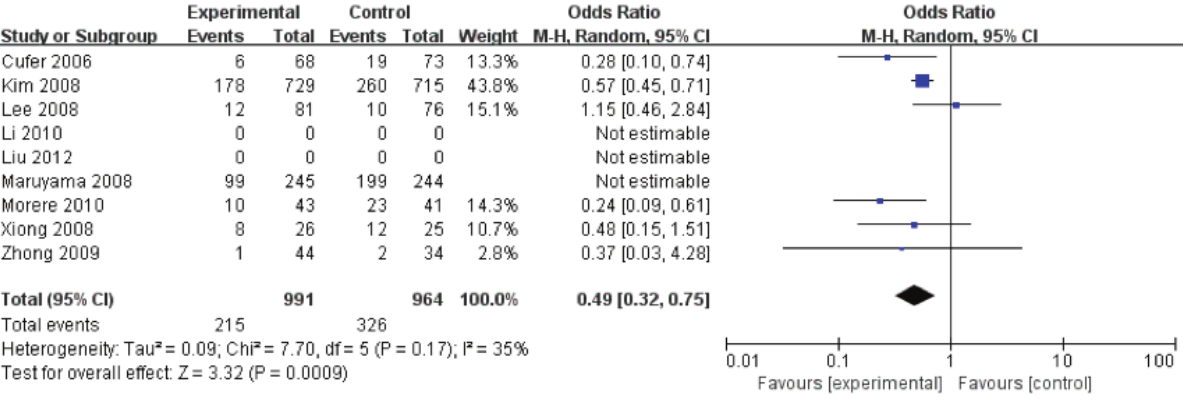
Figure 4: The comparison for the 3~4 grade adverse events between geftinib and docetaxel